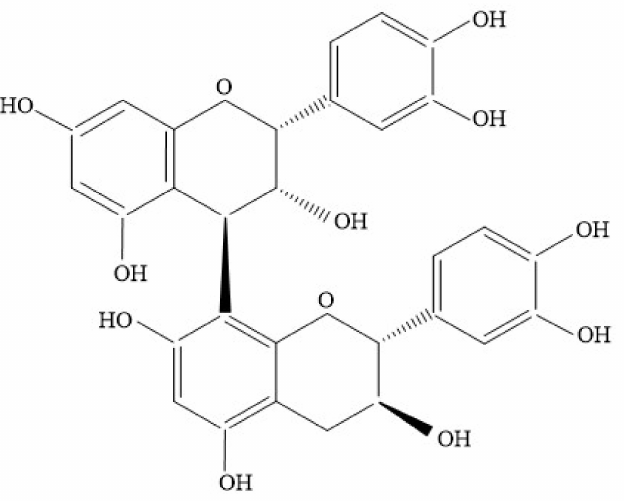
Figure 2. Structure of B1-type dimer procyanidin linked with a single C4 →